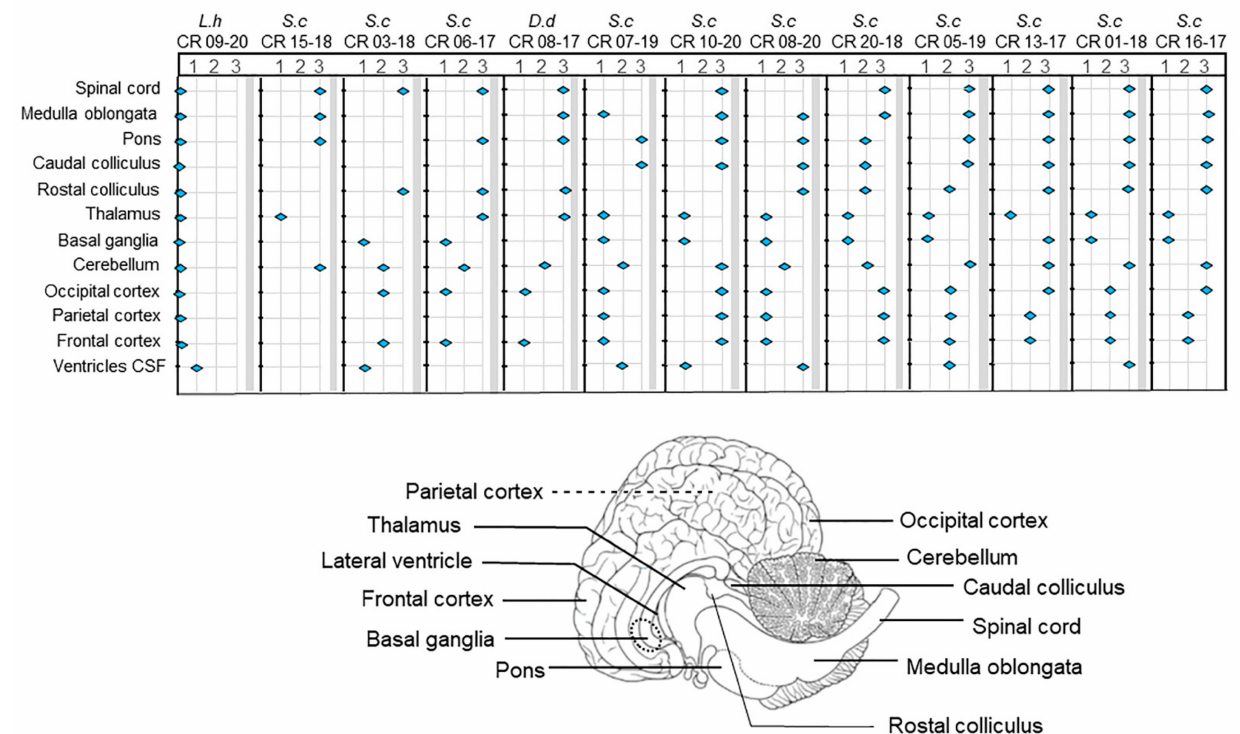
Figure 7. Inflammatory index of different central nervous system sections in dolphins with neuro- brucellosis. (1) Mild inflammation, (2) moderate inflammation, and (3) severe inflammation. Values below “1” indicate no inflammation. The location of the various brain tissues analyzed is depicted in the lateral brain section scheme. The amount (degree) of CSF in the lateral ventricles was estimated after necropsy of the brain, as shown in Figure